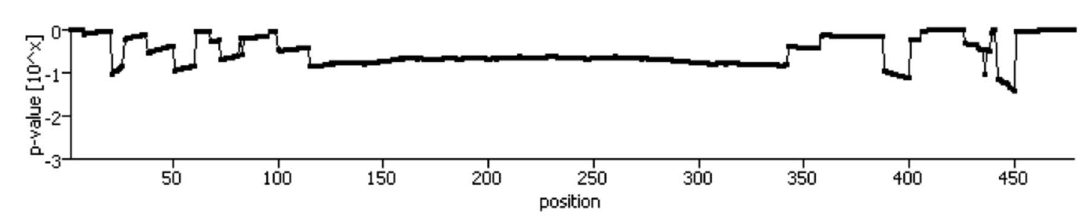
Figure 3. Graph displaying putative recombination breakpoints represented by downward peaks in the coat protein gene partial sequences of 32 accessions, and detected by the RECCO method based on cost